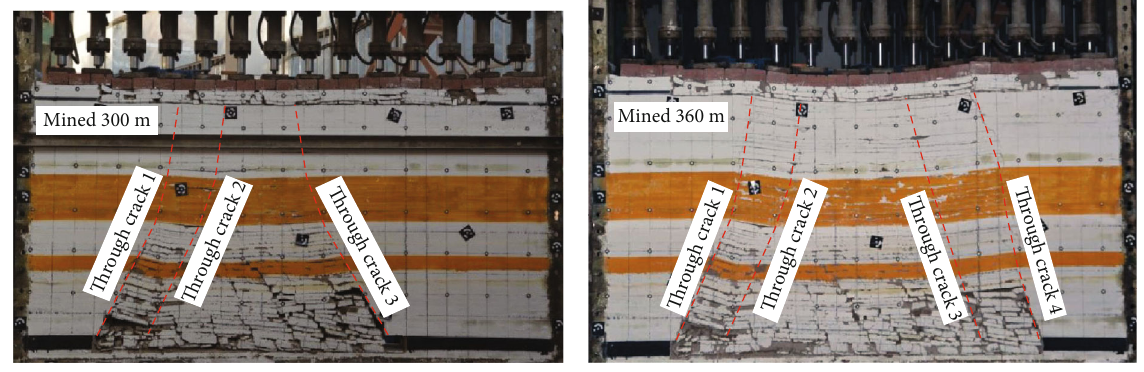
Figure 7: Fracture characteristics of the higher key